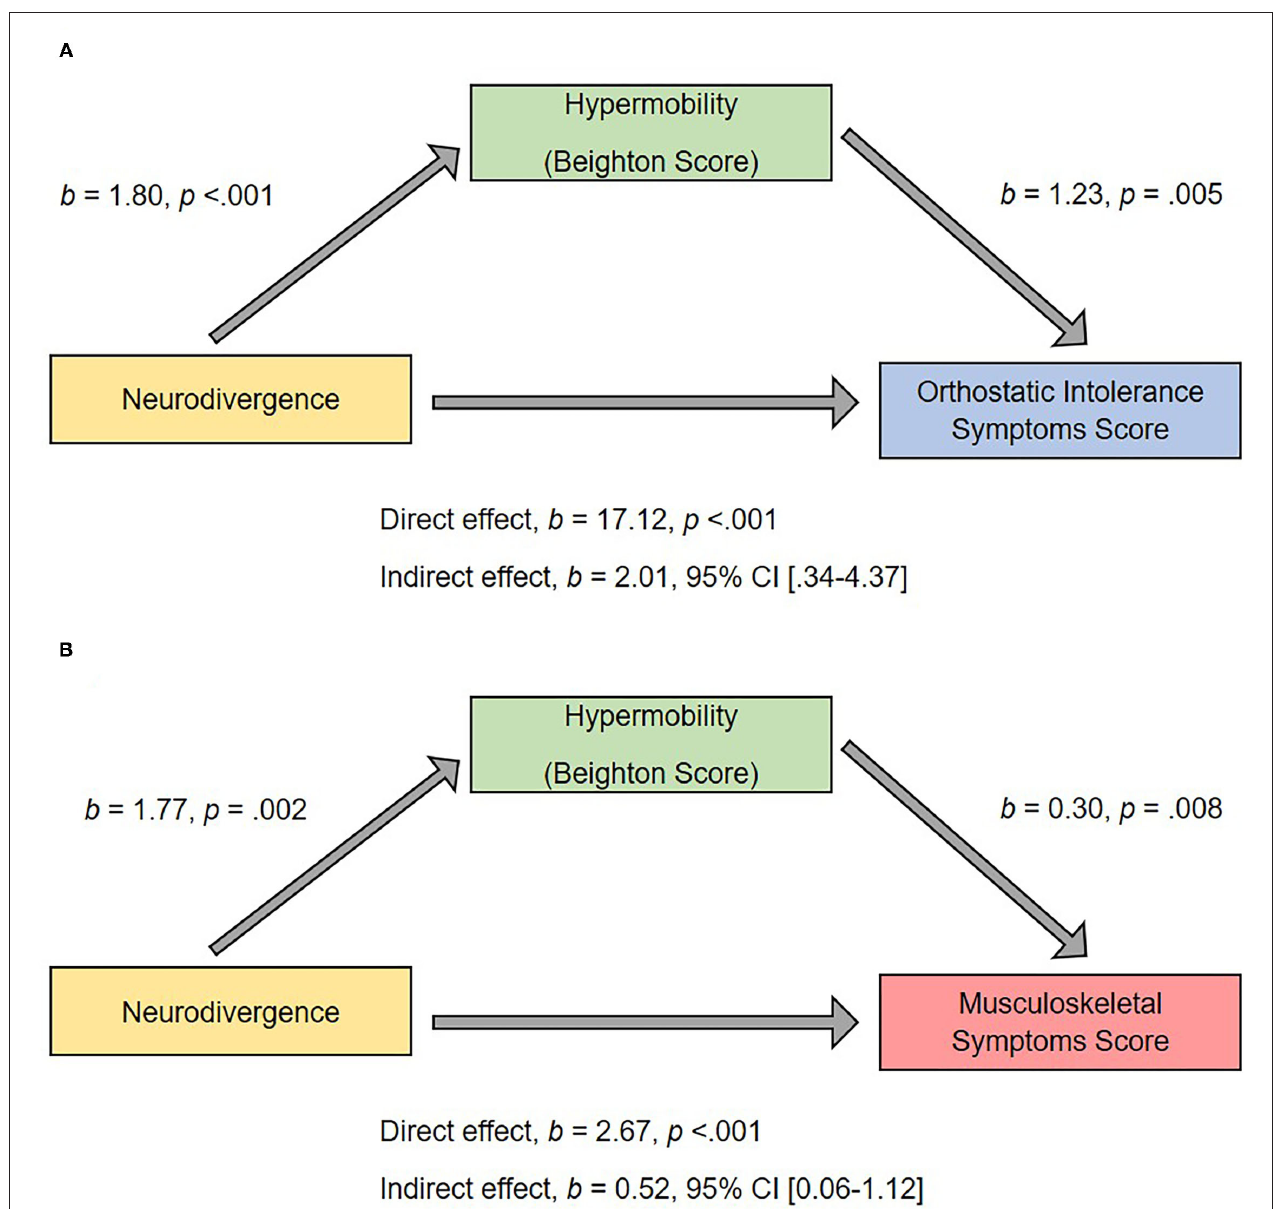
FIGURE 6 | Hypermobility as a mediator of predictor relationship between neurodivergent status and (A) orthostatic intolerance score; (B) musculoskeletal score. The confidence interval for the indirect effect is a bootstrapped confidence interval based on 1,000 samples.